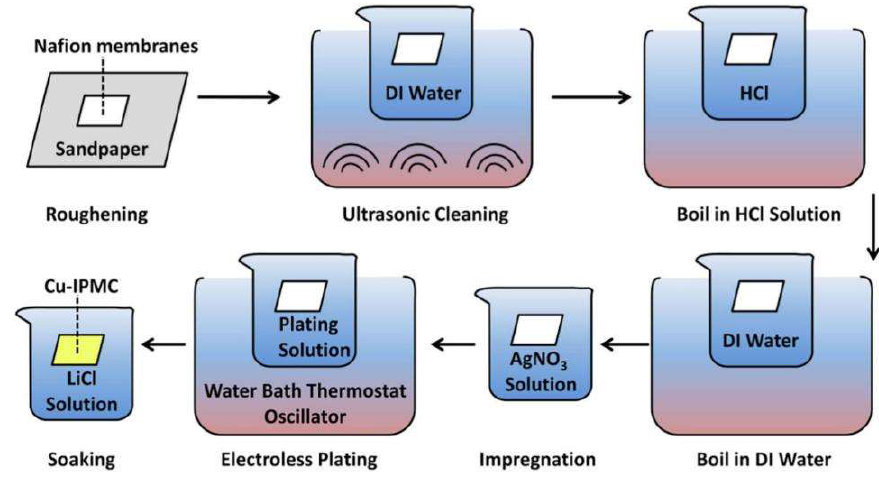
Figure 3. Traditional preparation process of IPMC